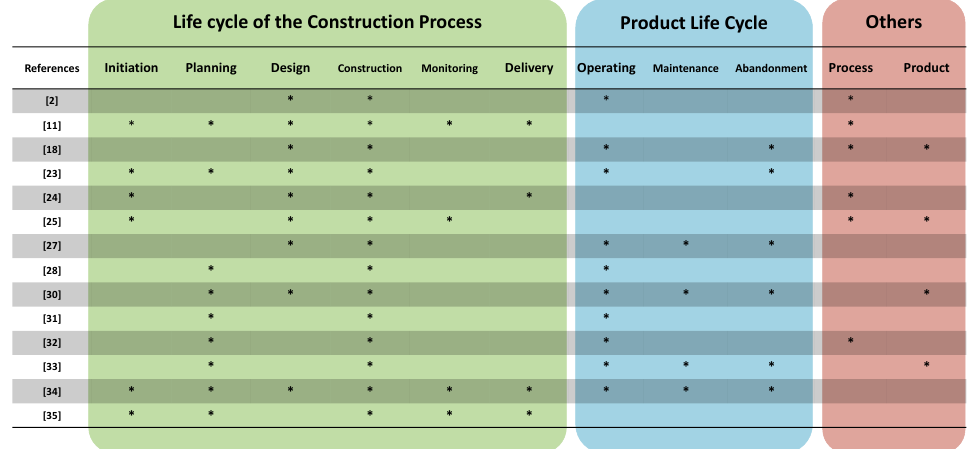
Figure 2. Comparison of phase inclusion for the process and product’s life cycle